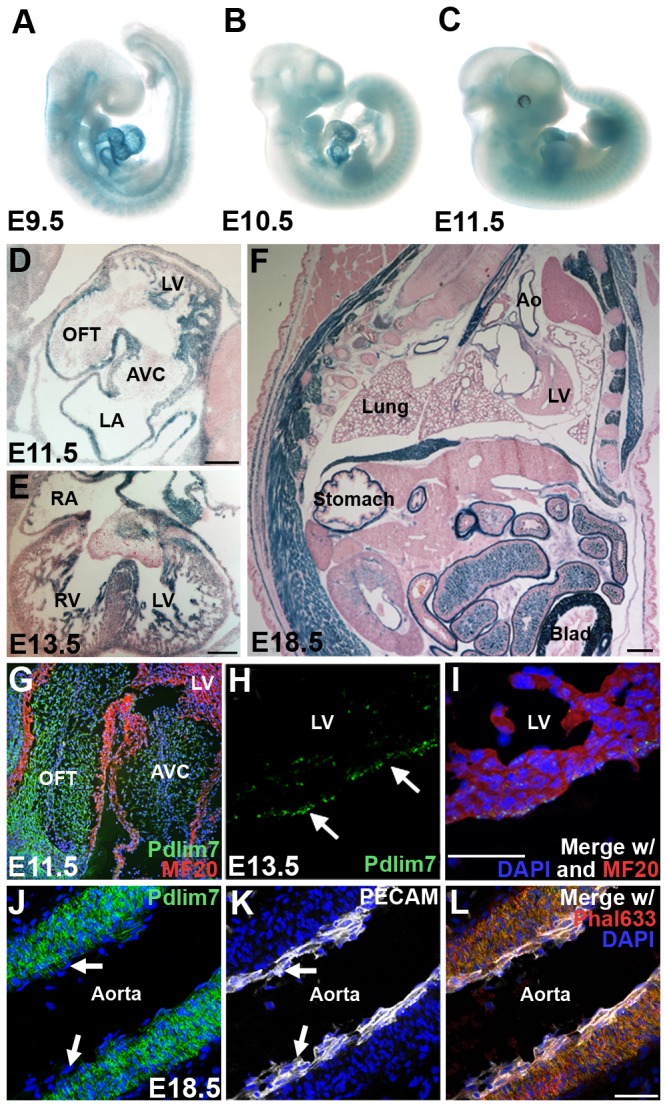
Pdlim7 is dynamically expressed in actin-rich structures throughout murine development.β-galactosidase staining of whole mount embryos identifies Pdlim7 early in the developing heart, forelimbs, hindlimbs, and somites (A-C). In E11.5 and E13.5 heart sections, β-galactosidase staining is localized to the trabeculated regions of the ventricles, atrial walls, and interventricular and atrial septa (D-E); of note: the β-galactosidase reaction time chosen does not reveal the lower levels of Pdlim7 expression in the cardiac cushion or valve cells. Sagittal sections of E18.5 embryos show Pdlim7 expression throughout the smooth muscle, including the lung alveoli, stomach, aorta, and bladder (F). Immunostaining of E11.5 hearts demonstrates Pdlim7 (green) localization to the outflow tract and atrioventricular cushions with MF20 positive myocardial cells (red) (G). Pdlim7 (green) proteins are also detected in the epicardium of E13.5 embryos (arrows, H-I) with MF20 positive myocardial cells (red) and DAPI nuclei (blue). In the aorta, Pdlim7 proteins (green) localize to filamentous actin (red) of smooth muscle, but not PECAM-positive endothelium (white) (arrows, J-L), control DAPI nuclei (blue). Scale bar = 200μm (D-E) and 50 μm (F, I, L). Ao = Aorta; AVC = atrioventricular cushion; Blad = bladder; LA = left atrium; LV = left ventricle; OFT = outflow tract; RA = right atrium; RV = right ventricle.